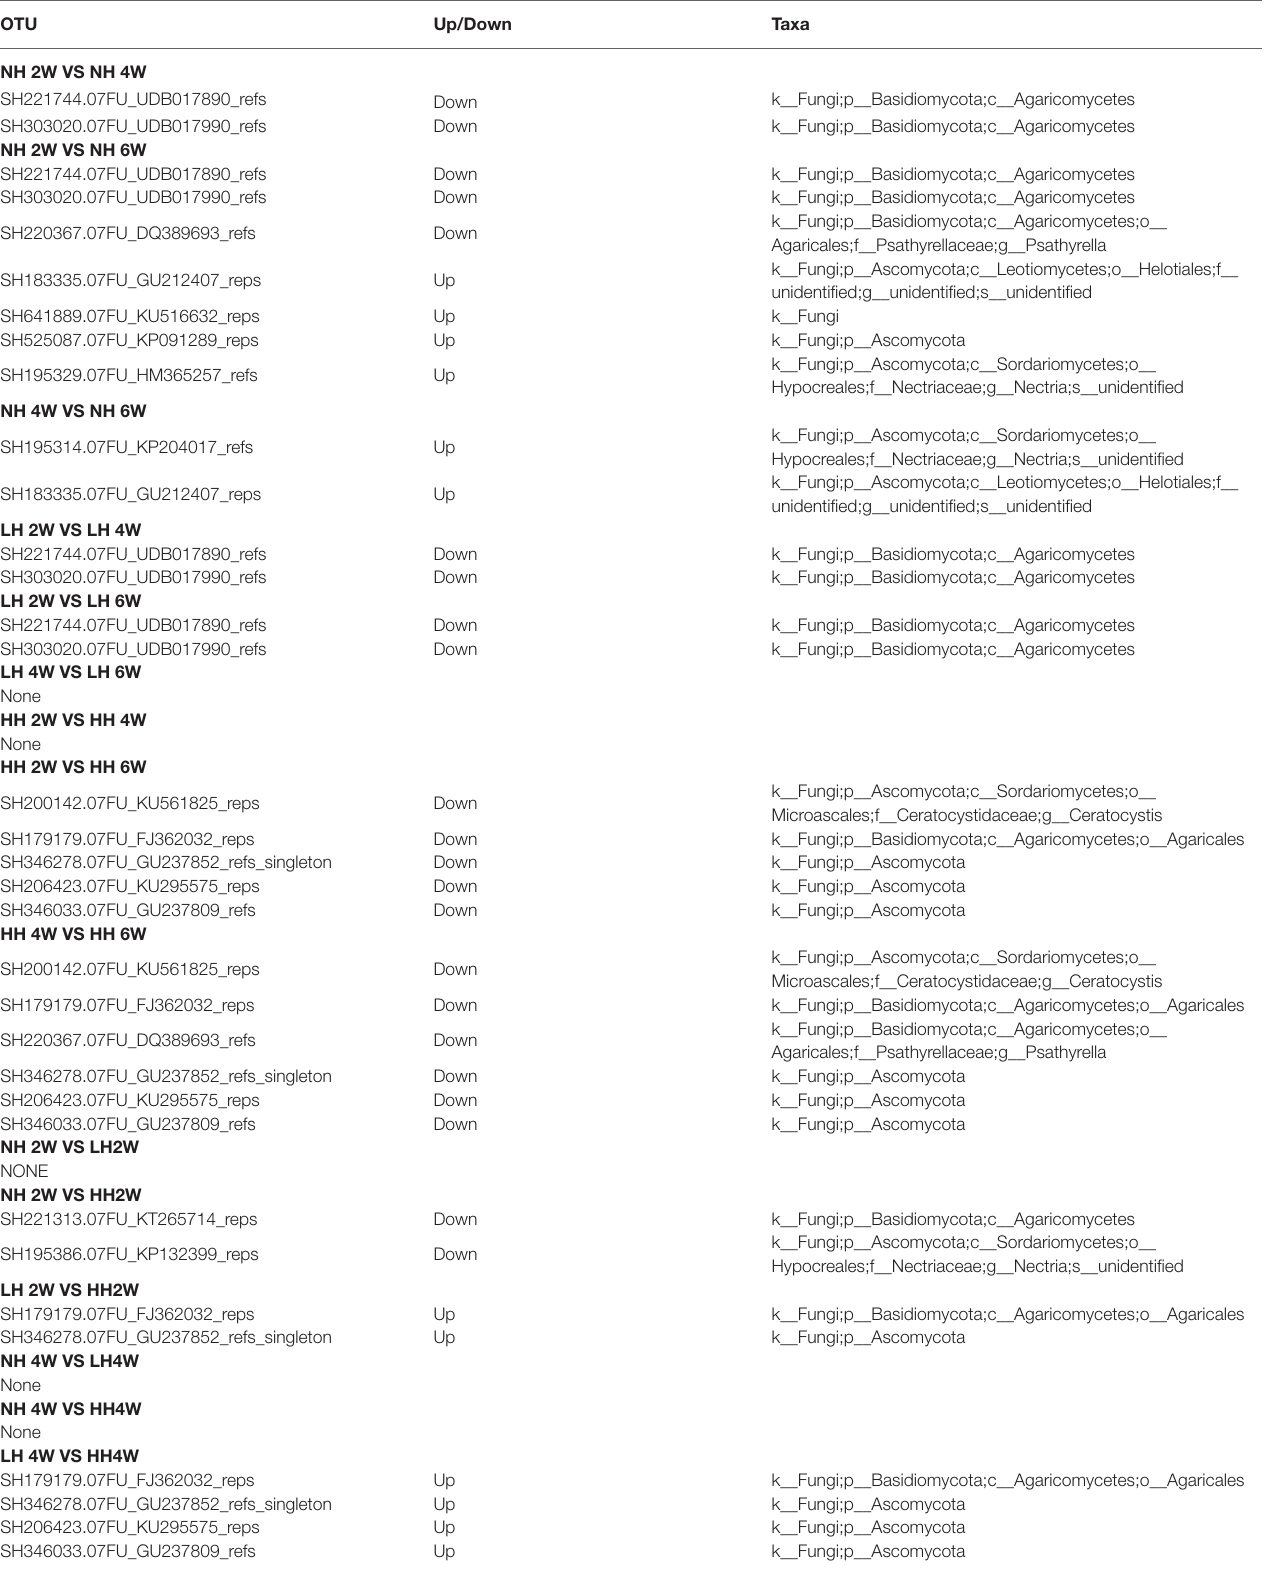
TABLE 2 | Significantly altered fungal OTUs between treatments, as affected by a different herbivory intensities and time since herbivore removal. OTU Up/Down